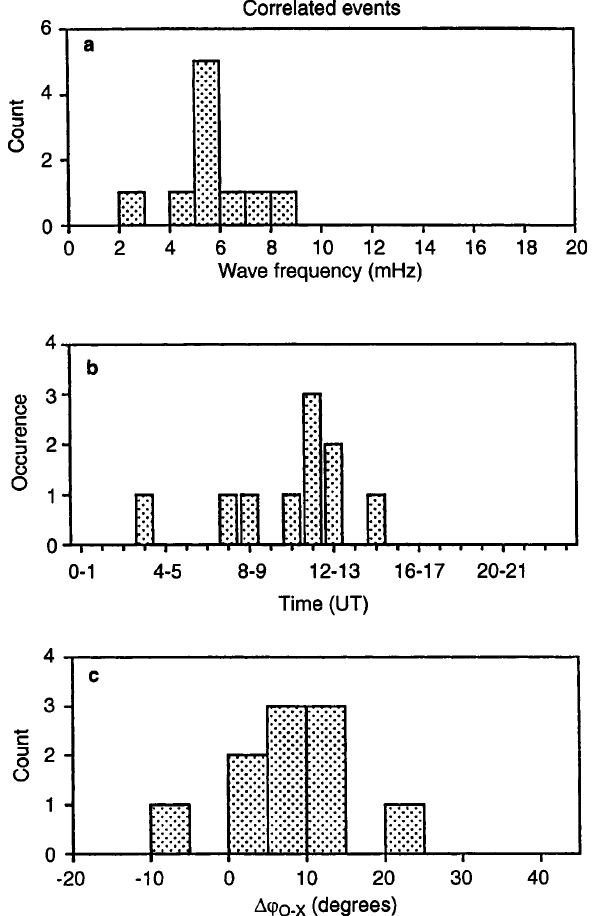
Fig. 4a–c. Characteristics of the correlated wave signatures for the 10 events studied in Paper 1 (see main text): a ULF wave frequency, b diurnal occurrence and c D u , the relative phase of the signatures O-X in the O- and X-mode HF